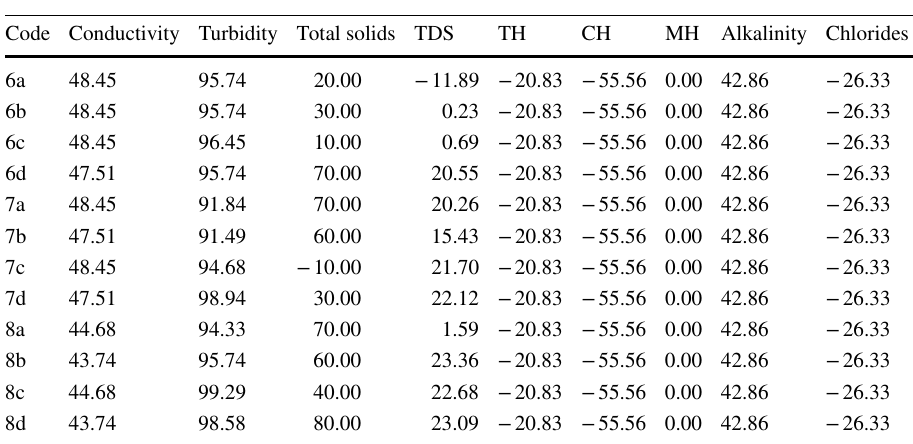
TDS total dissolved solids, TH total hardness, MH